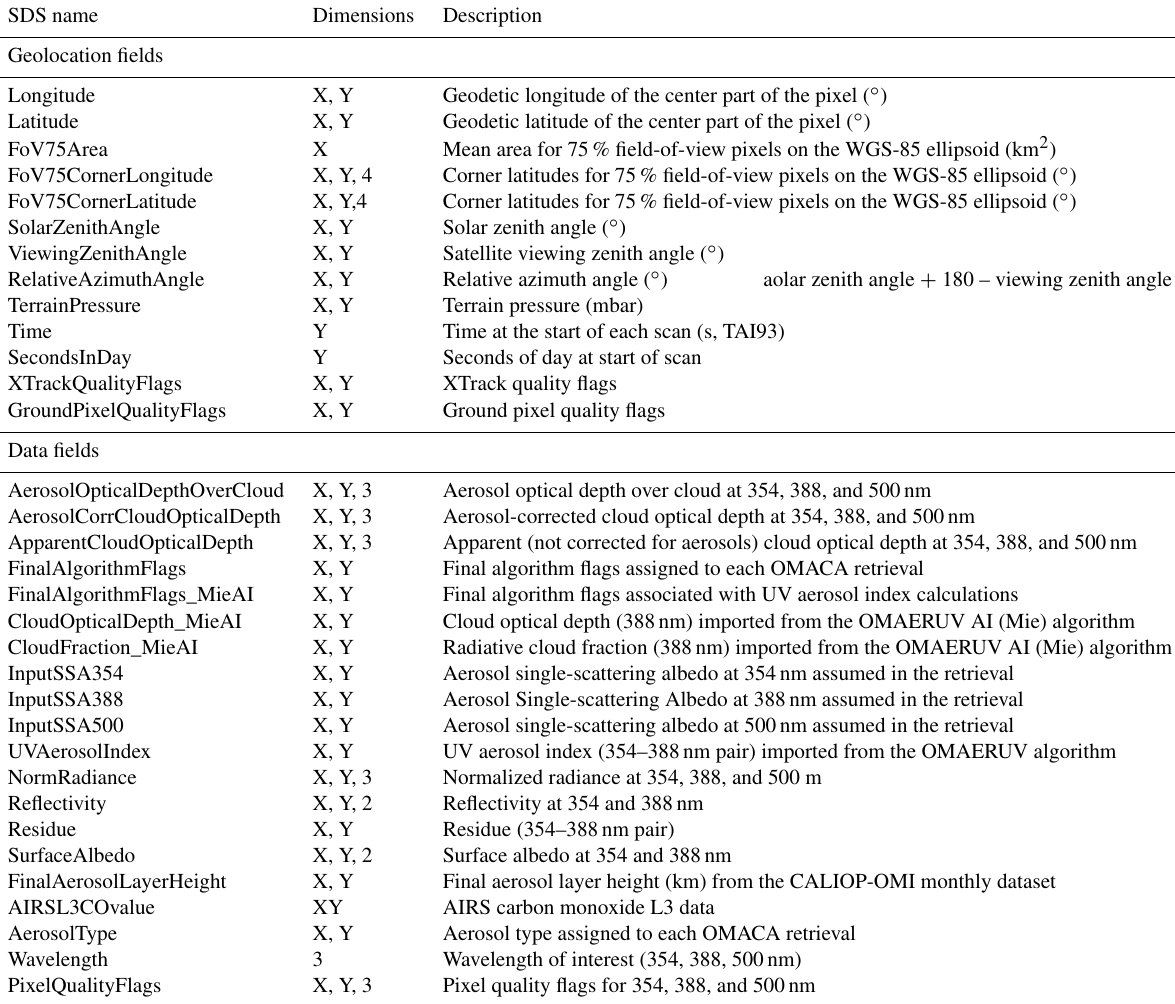
Table A5. Content of OMACA HDF-EOS5 data